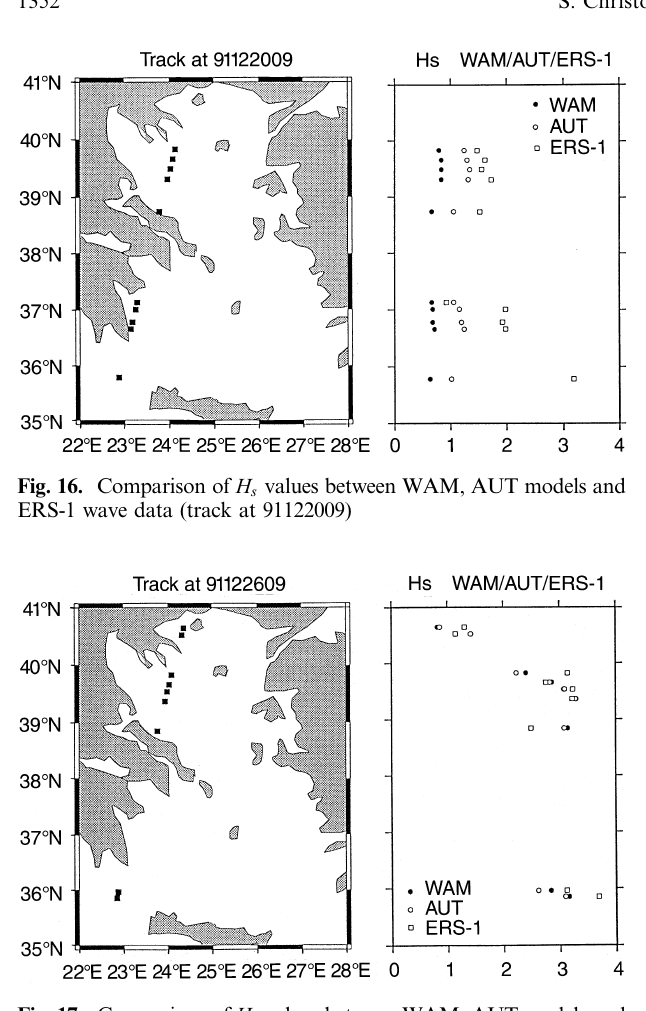
Fig. 17. Comparison of H s values between WAM, AUT models and ERS-1 wave data (track